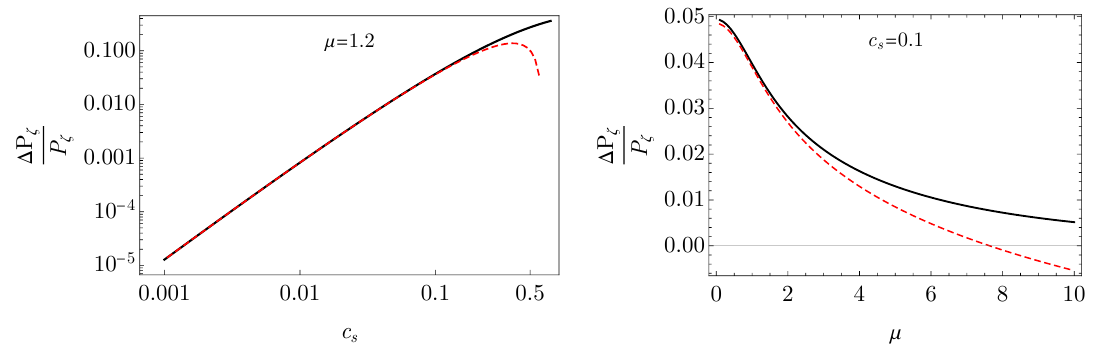
Figure 9 . Left : The fractional shift in the power spectrum of ζ (due to the exchange of σ ) as a function of the speed of sound. The black curve is the exact result (3.31), and the dashed red is the asymptotic behaviour (5.1) for a small enough mass c different values of µ . As expected, for masses in Hubble units of order 1 /c µ ∼ 10 ) the small sound speed results starts to deviate from the exact one. In both diagrams we have set ρ/H = 1